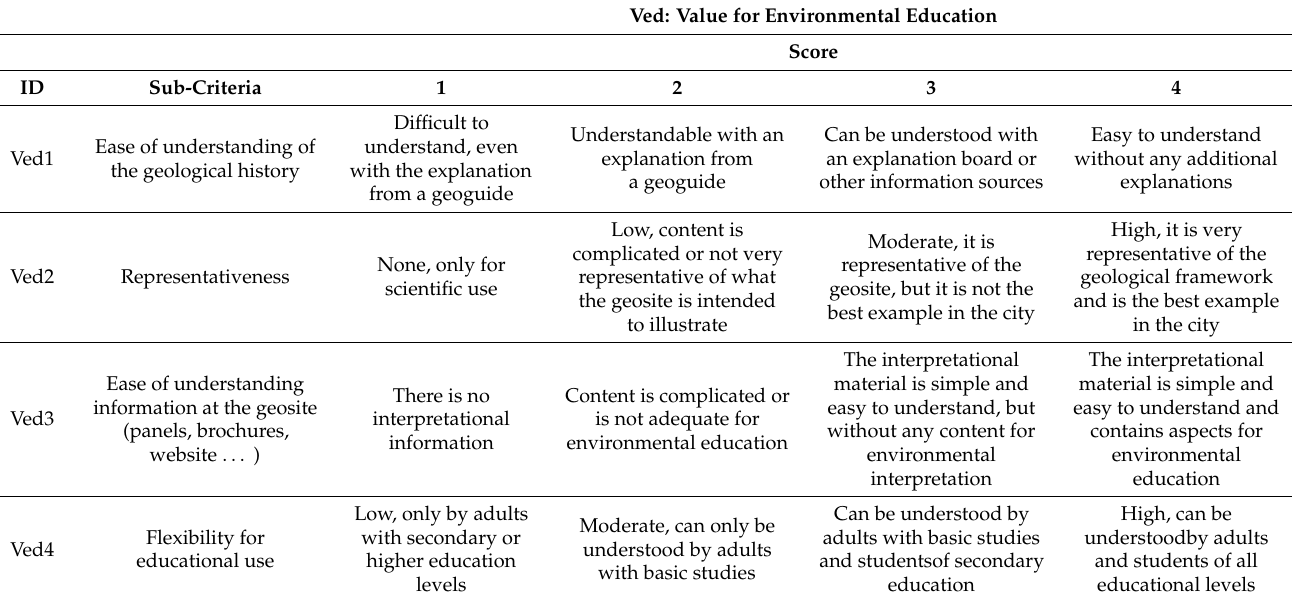
Table 1. Value for environmental education and sub-criteria